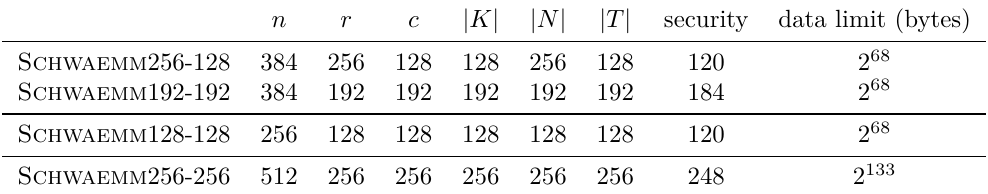
Table 3: The AEAD instances with their (joint) security level in bit with regard to confidentiality and integrity and the limitation in the data to be processed.